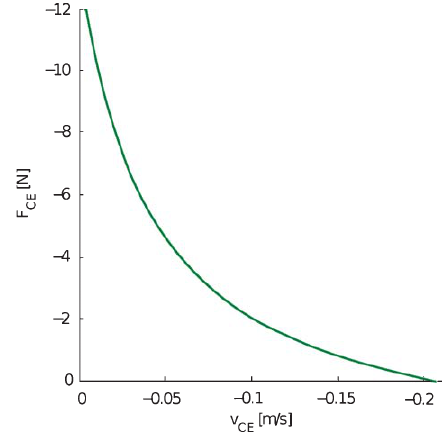
Fig. 1. Force-velocity relation of a rat gastrocnemius muscle as measured by [26] and theoretically predicted by [8].